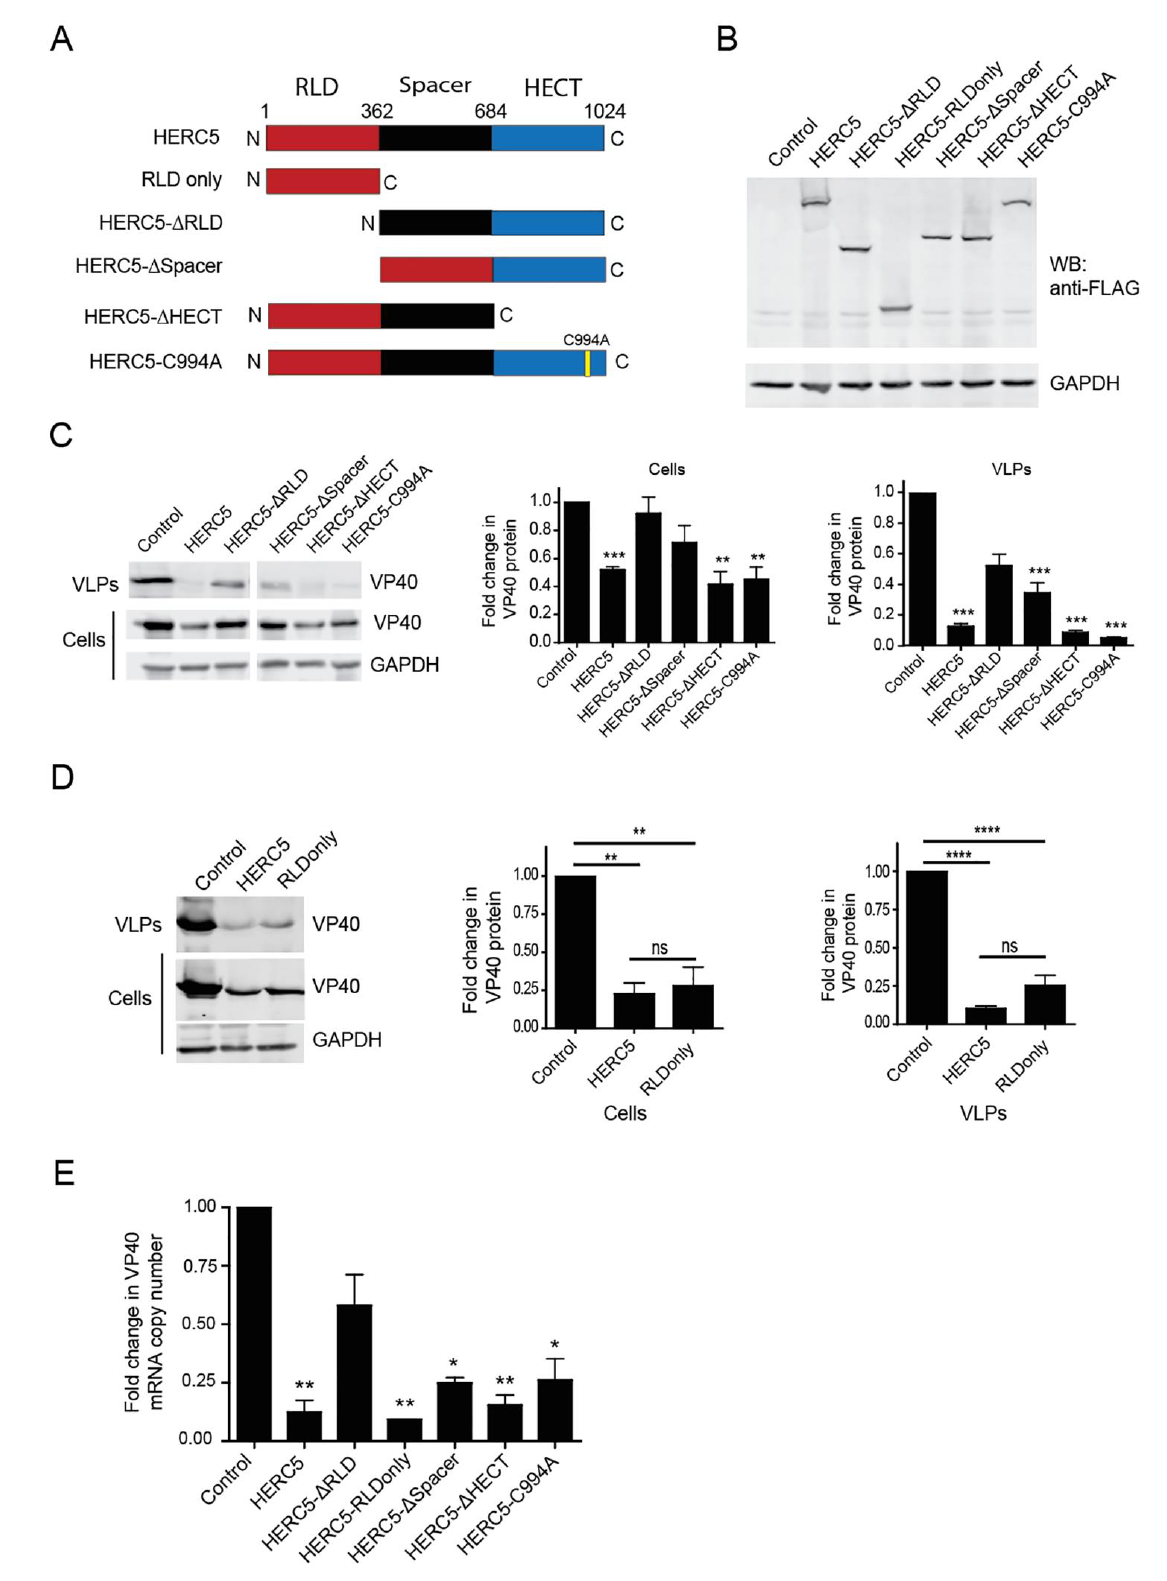
Figure 3. The RLD is necessary and sufficient for HERC5-mediated restriction. ( A ) Schematic of the different HERC5 mutant constructs. ( B ) Representative Western blot showing consistent expression of wild-type HERC5 and mutant forms of